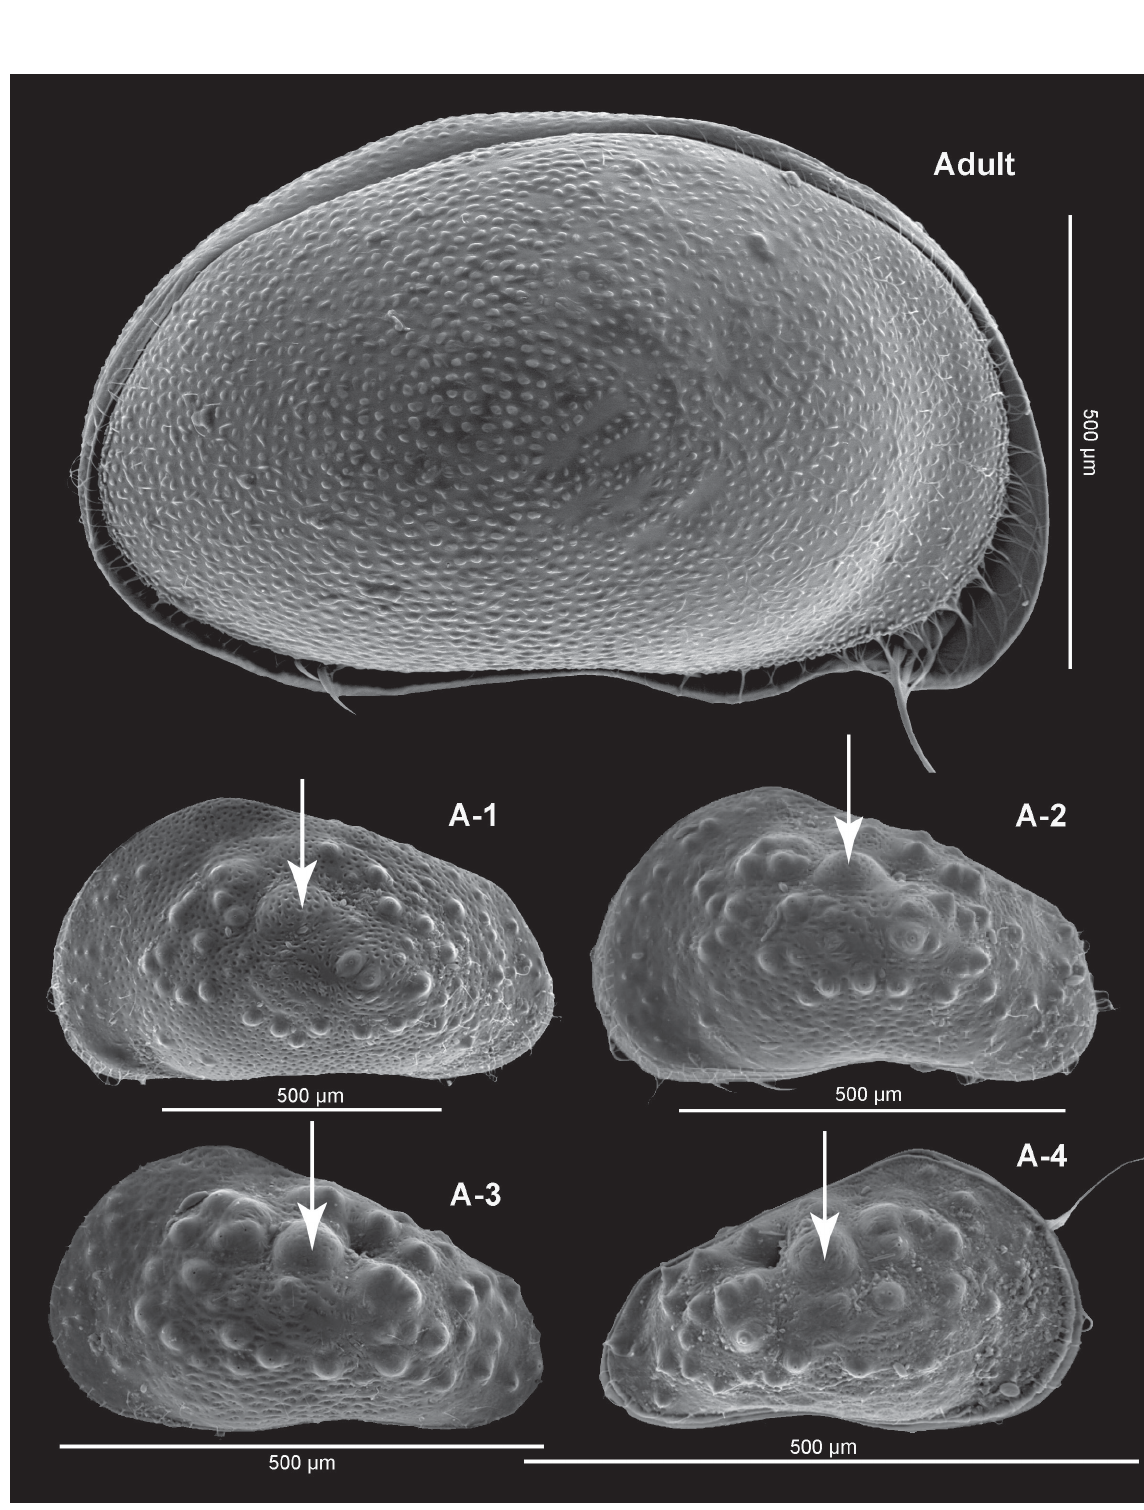
Fig. 2. External lateral views of Bennelongia cf . nimala nov. sp. from Muggon Lake. Top . adult carapace in right lateral view. Note the pronounced asymmetry of the valves, especially in the anterior region. Middle . LV of A-1 and A-2 specimens. Bottom . LV of A-3 specimen and RV of A-4 specimen. Domes are